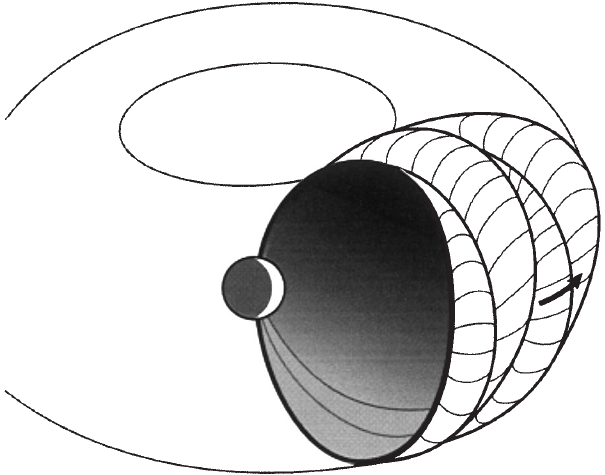
Fig. 11. Sketch of the antisymmetric packing of field inflation and compression caused by the high-beta plasma blobs. The longitudinal separation at (cid:24) 11 R E is of order 1–2 R